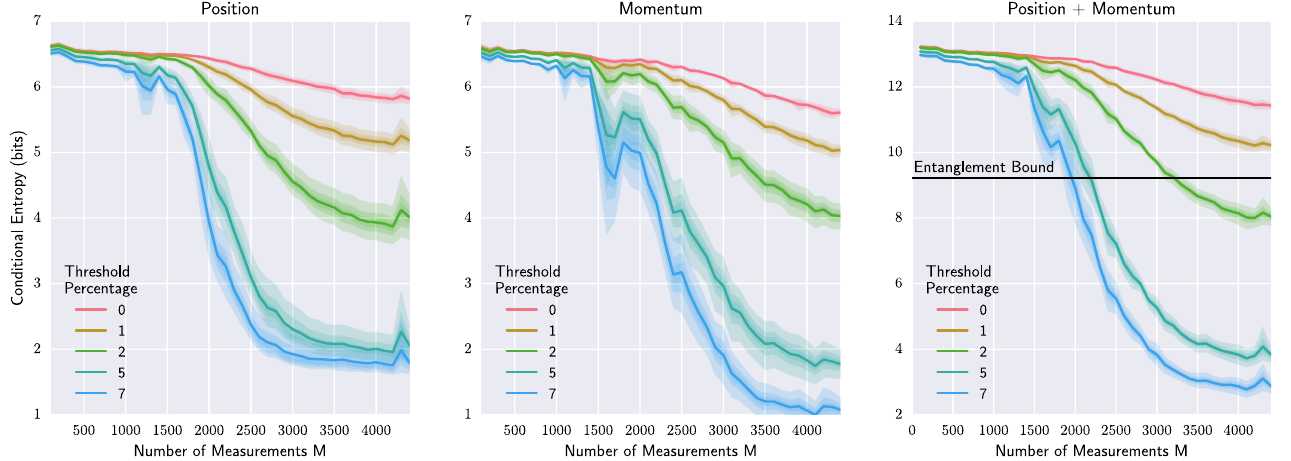
FIG. 5. Conditional entropy versus measurement number. A sharp transition from high to low conditional entropy is seen as the number of measurements increases. Note that N ¼ 256 2 , so M ¼ 2 , 000 is only 0 . 03 N . Different curves correspond to different levels of thresholding to remove the noise floor. Bold lines indicate an average over nine trials. Faded lines enclose up to 4 standard deviations about the mean. When the conditional entropy sum is below the bound, the state is entangled.